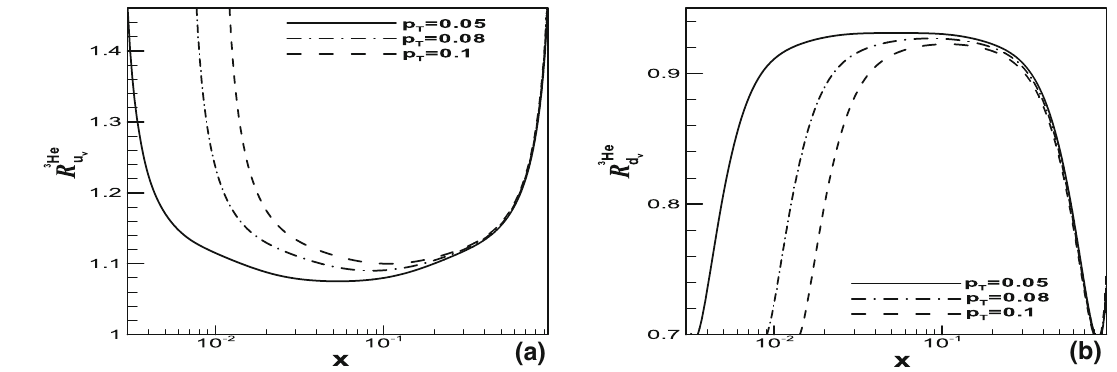
Fig. 9 The ratios of TMD valence quark, a u v and b d v , distributions of 3 He and deuteron with respect to x at three values of p T